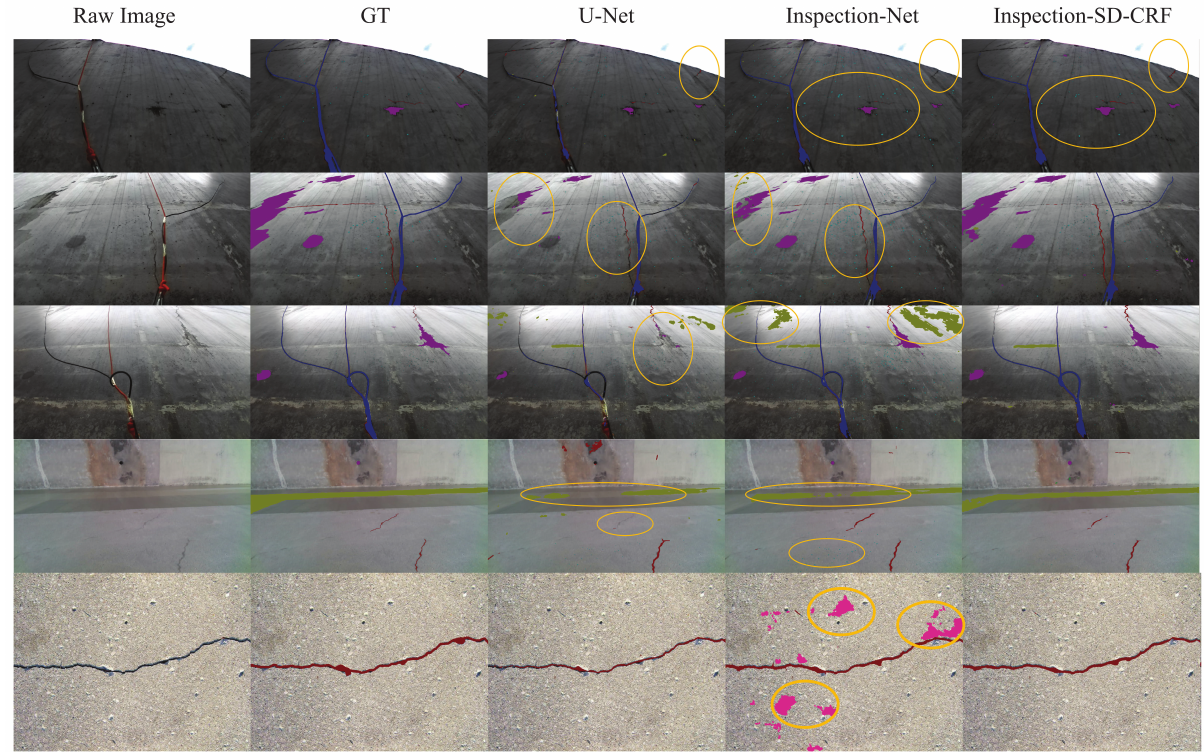
Figure 9. Segment results on different dataset and images. We selected some representative images from the segmentation results of the DSI and CSSC datasets, and the orange ellipses circle the parts with obvious contrast in the segmentation